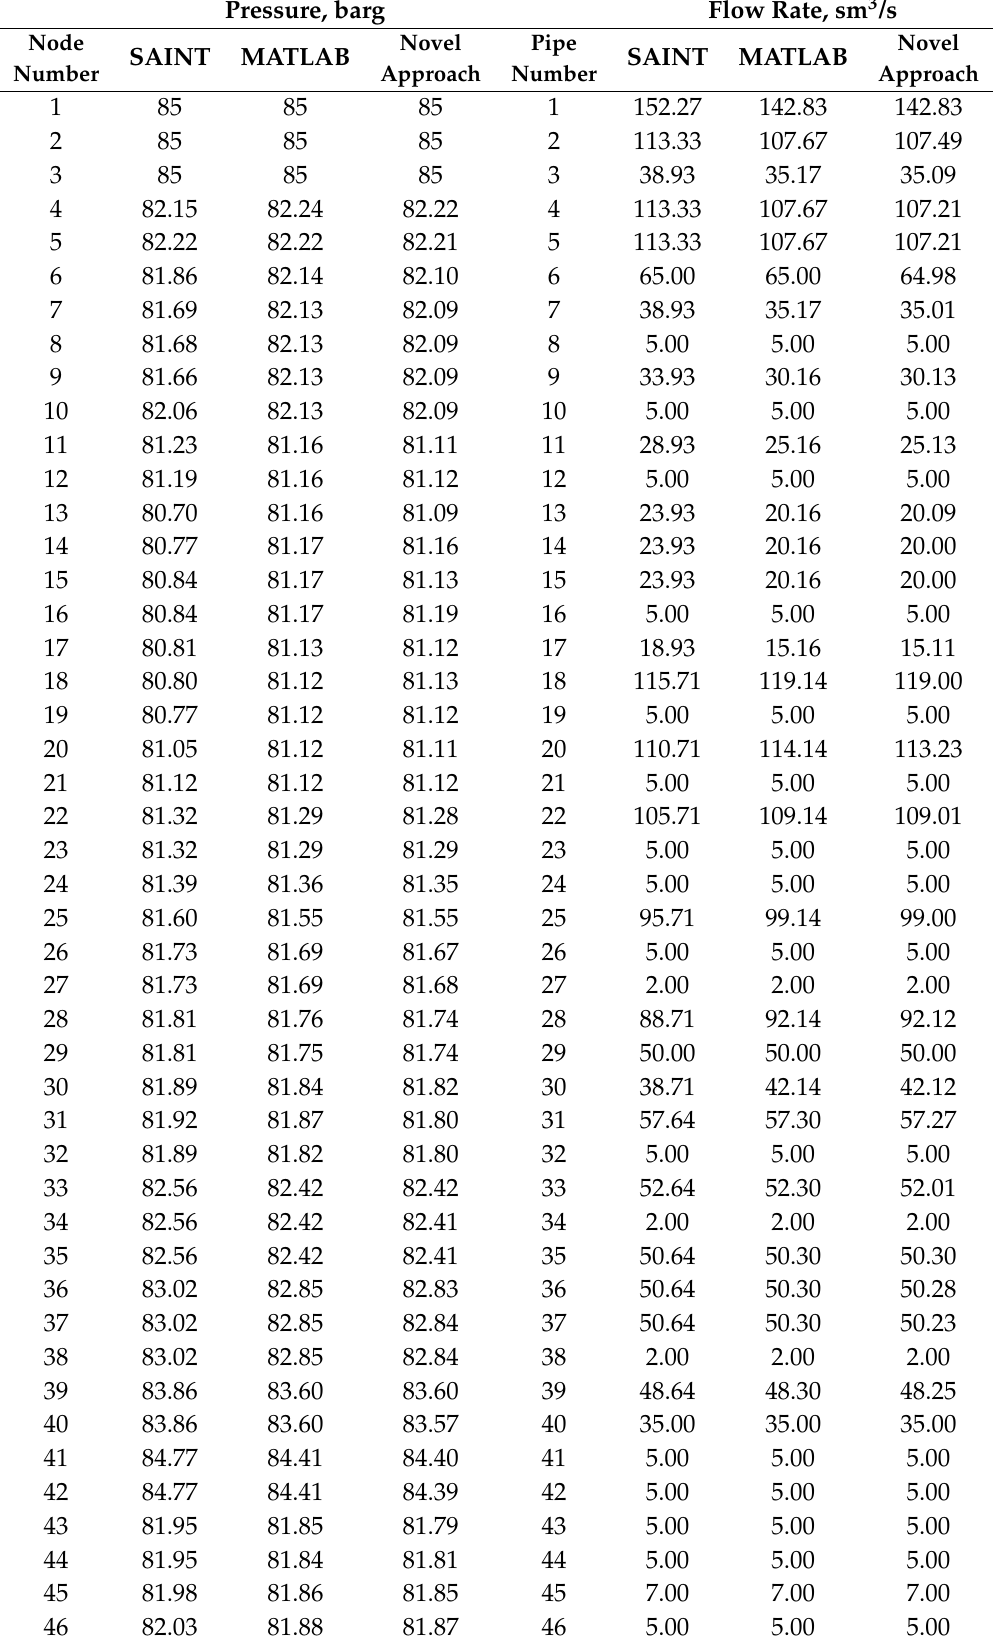
Table A2. SAINT, MATLAB, and the novel method outputs for a 109-node